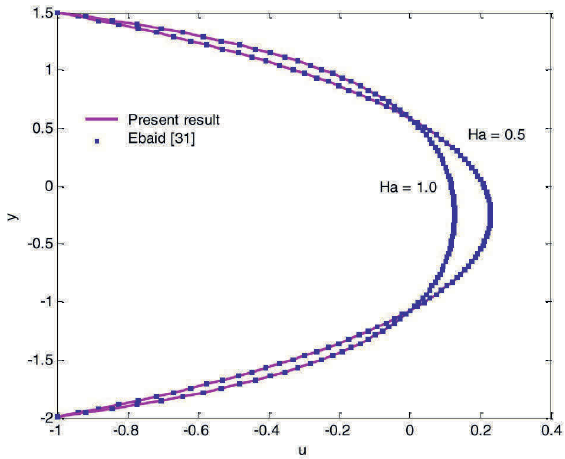
Fig. 2: Comparison of axial velocity for two distinct values of Ha .